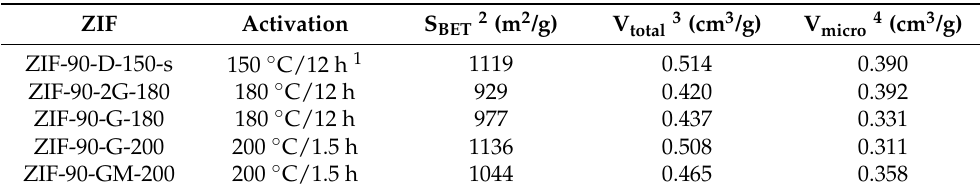
Figure 5. N 2 adsorption isotherms for fully activated (ZIF-90-G-200, ZIF-90-GM-200), while the inset shows partially activated (ZIF-90-G-180) and reference (ZIF-90-D-150-s) samples.